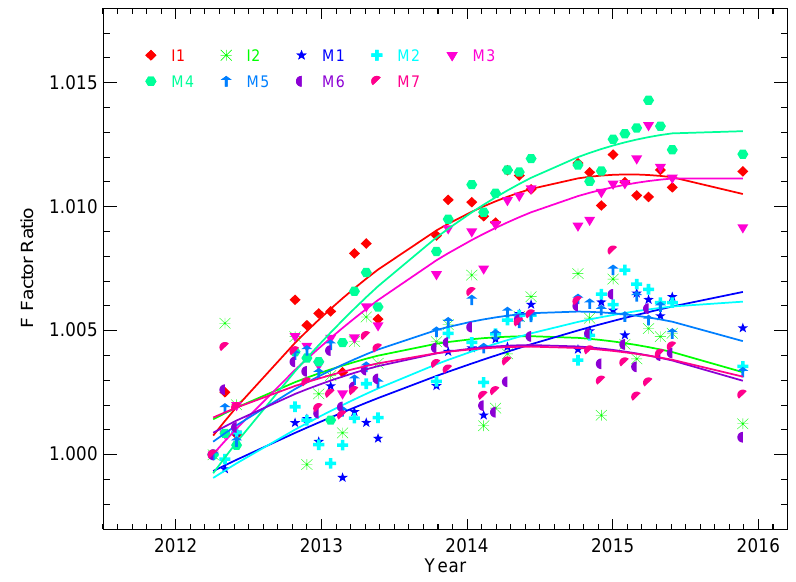
Figure 13. Ratios of lunar F-factors over SD F-factors.